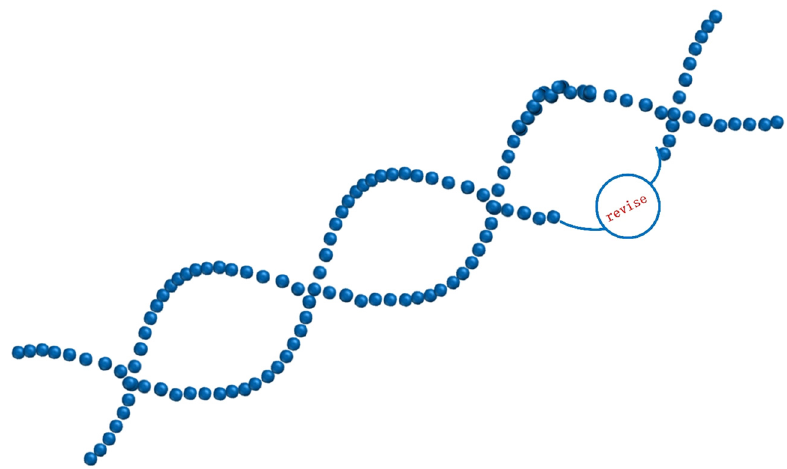
Figure 8: Repair molecules to connect damaged DNA by